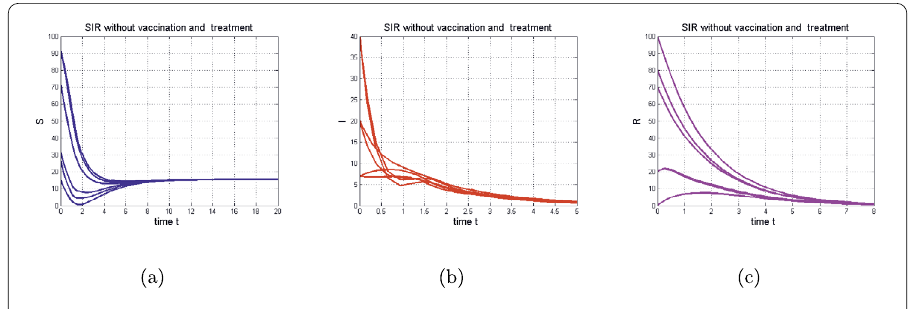
Figure 2 The time series of model (3) in the special case (12), with Figures ( a ), ( b ), and ( c ) representing (respectively) S ( t ), I ( t ), and R ( t ). The parameters of the model are b = 10, μ = 0.65, β = 0.2, c = 0.77, γ = 0.75,